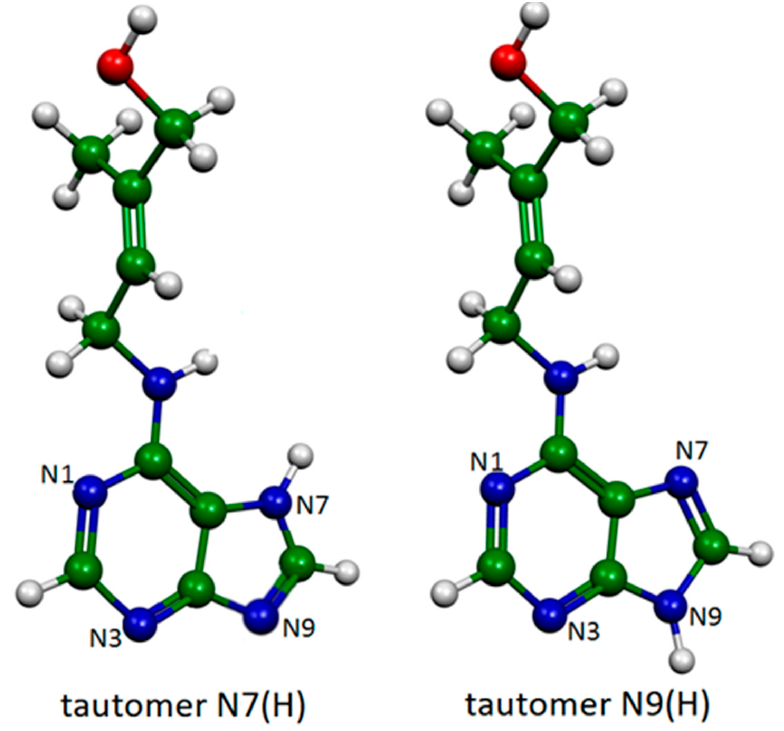
Figure 5. Tautomeric forms of trans-zeatin.